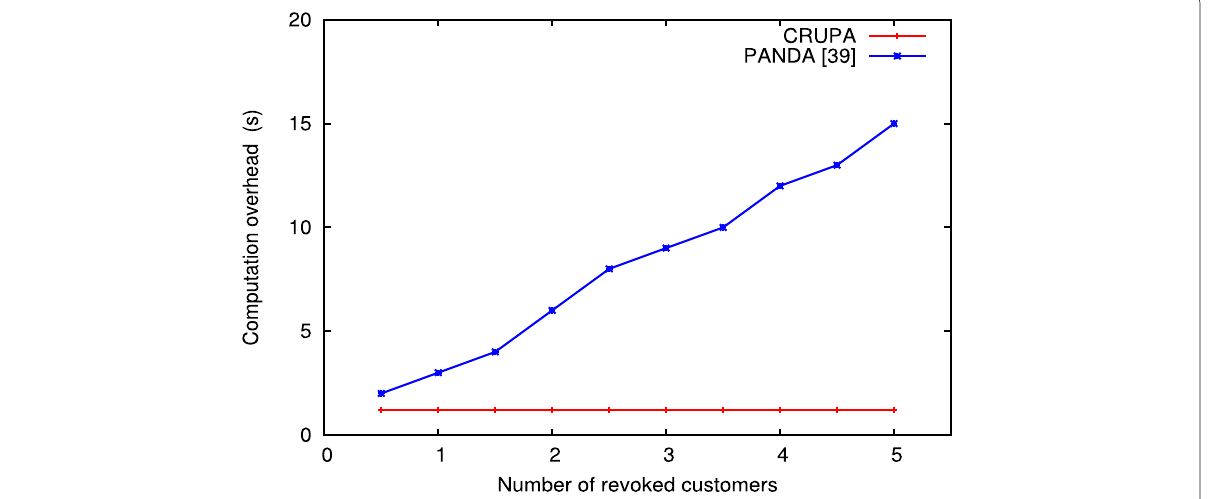
Fig. 3 Computation of Re − sign key by Information